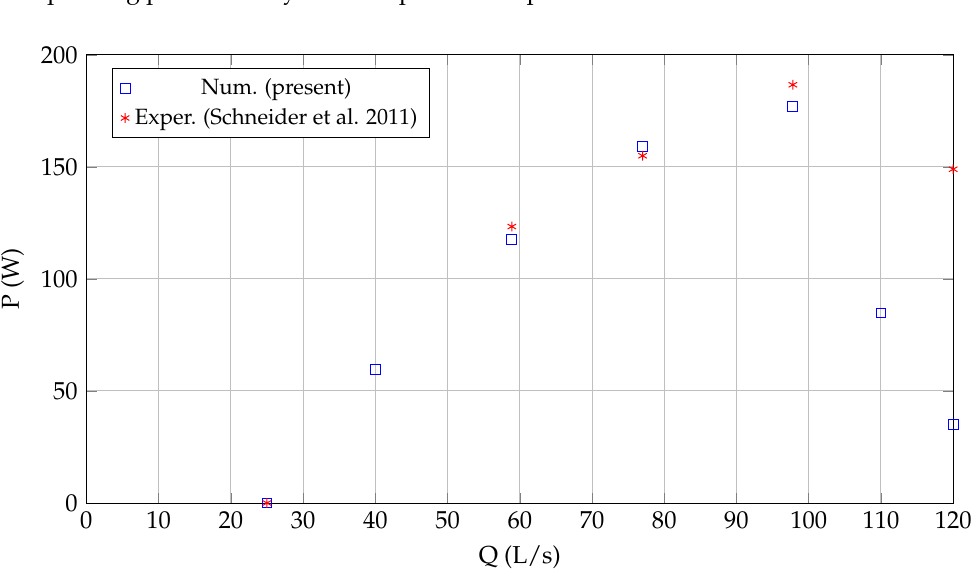
Figure 14. Power—Discharge curve of the HPM. Comparisson of numerical with experimental results presented in Schneider et al. (2011) [38].